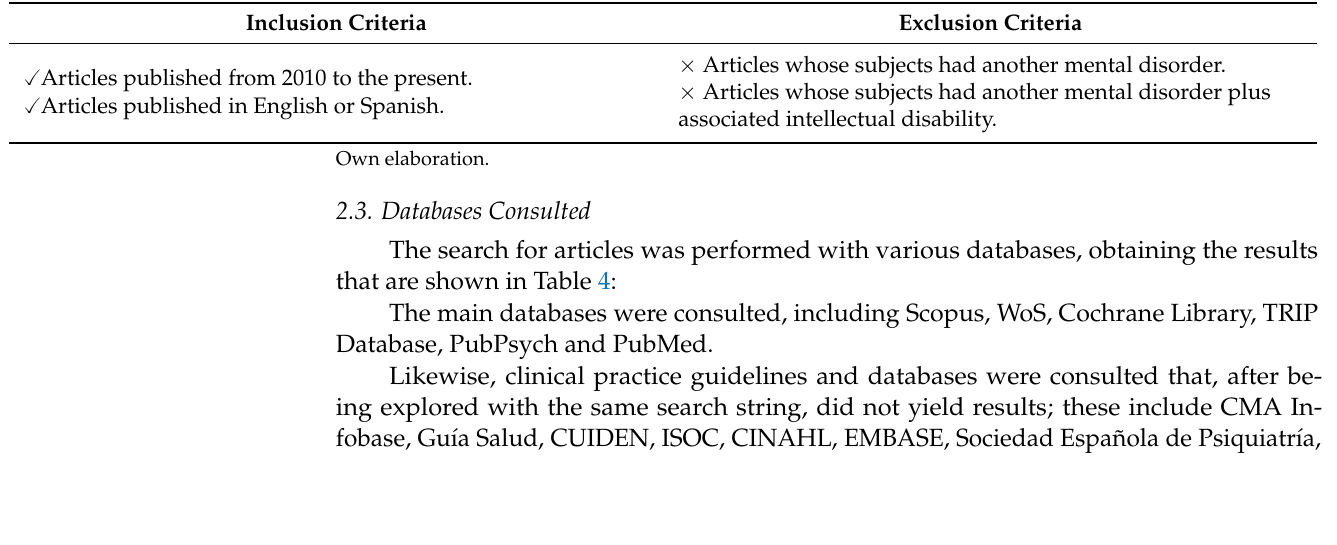
Table 3. Criteria for inclusion and exclusion of